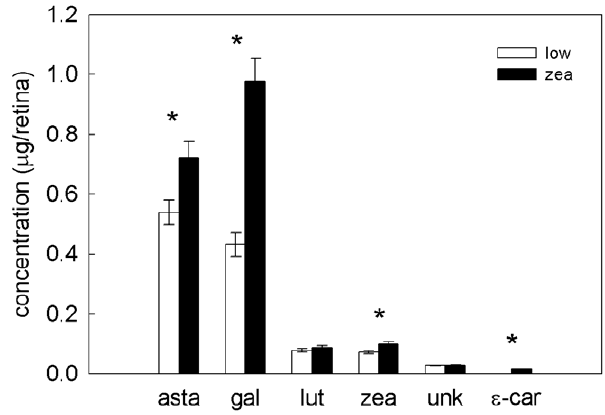
Figure 2. Retinal carotenoid levels in experiment two. Mean 6 S.E. concentration of the six carotenoid types in retinas of female finches receiving a low-carotenoid (open bars) or zeaxanthin-supple- mented (solid bars) diet in experiment two. *indicate significant